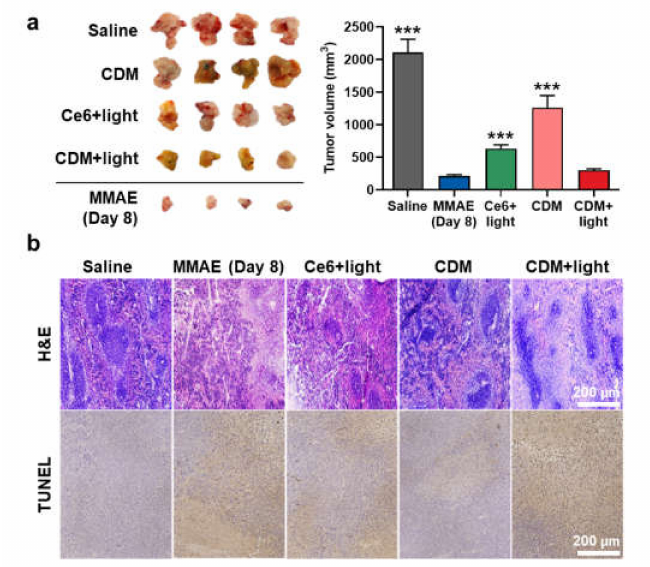
Figure 4. In vivo therapeutic efficacy of CDM in orthotopic pancreatic cancer models. ( a ) Optical images and volume of cancer tissues from orthotopic pancreatic cancer models after treatment with saline, MMAE, Ce6, or CDM. The tumors of Ce6- or CDM-treated mice were locally irradiated with visible light with power of 160 mW for 10 min. The asterisks in Figure indicate the comparison to the CDM+light group. ( b ) Pancreatic cancer tissues stained with H&E or